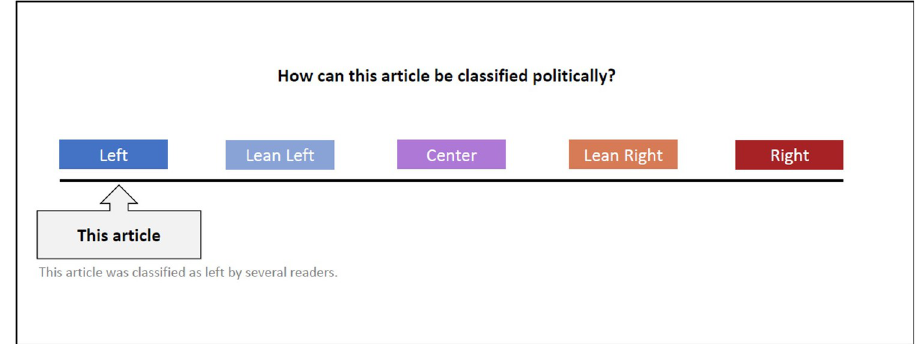
Fig 2. Political classification bar. Example of an article classification as being politically